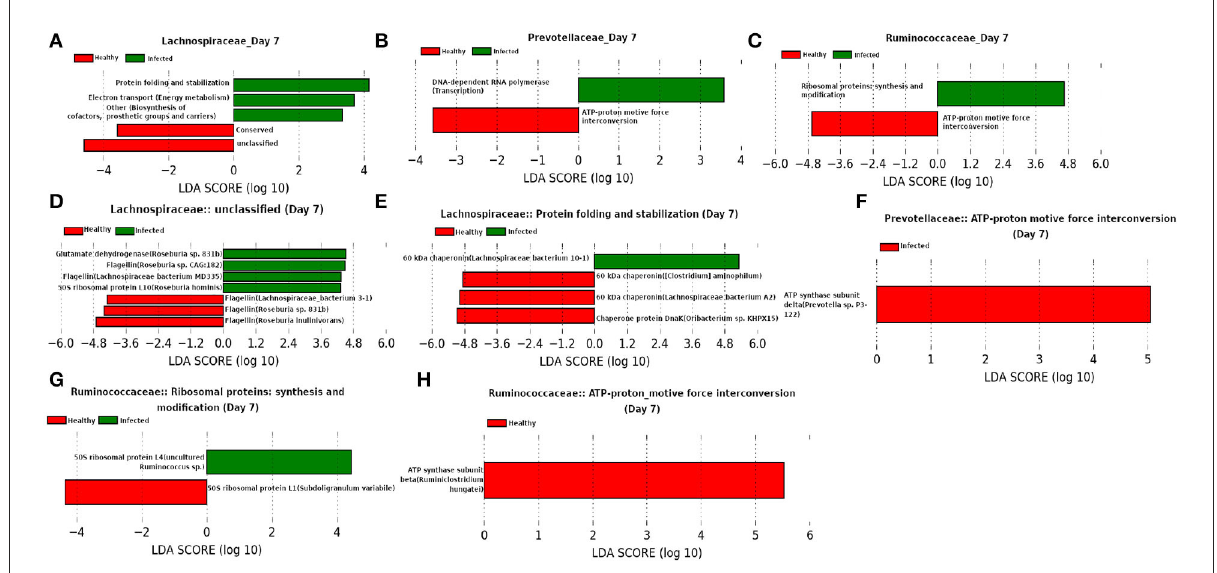
FIGURE13 (A–C) Linear discriminant analysis effect size (LEfSe) scores of the enriched functions of the dominant microbiome family, ASVs of which are found to be the member of infected-core-hub community or act as hubs or key-drivers in the infected cohort at day 7. (D–H) Linear discriminant analysis effect size (LEfSe) scores of the predicted biomarkers involved in the enriched microbial functions associated with healthy and infected cohorts at day 7.